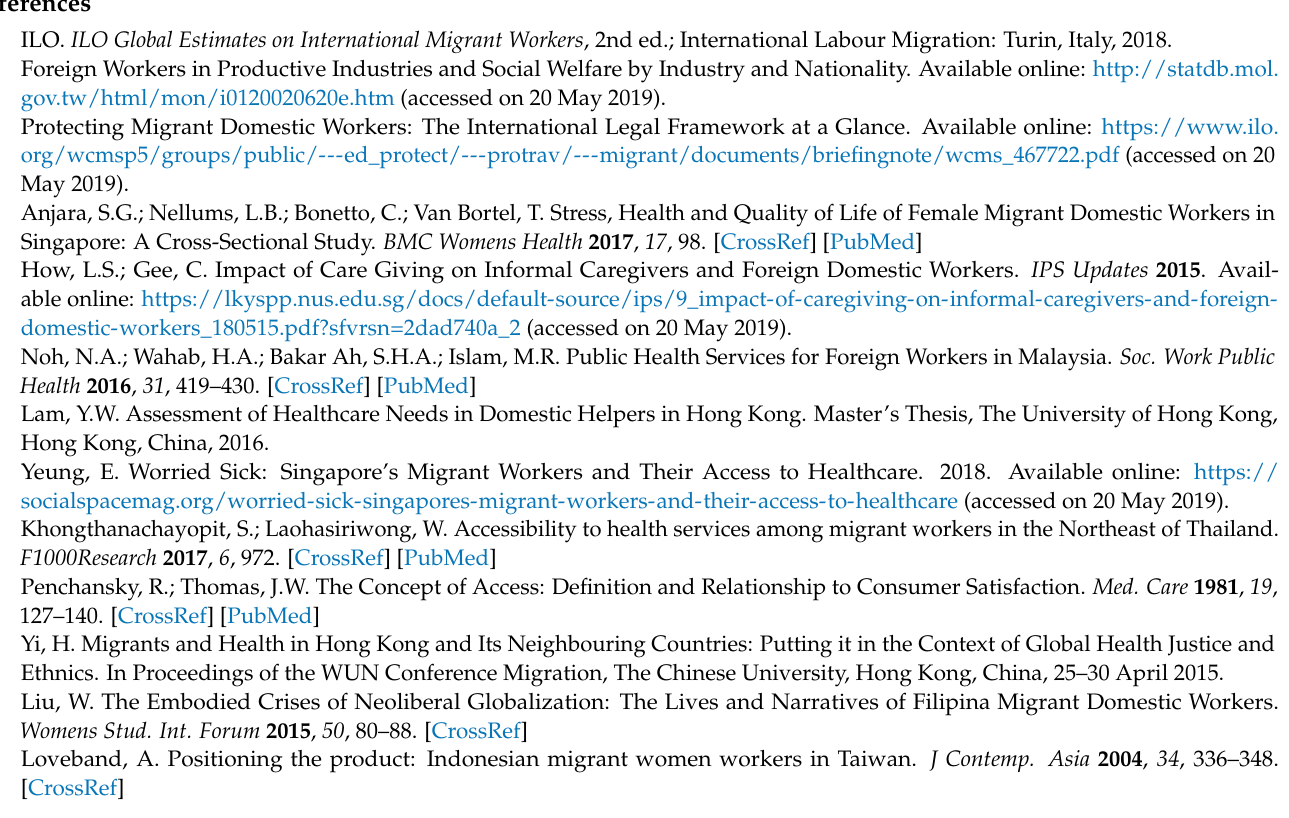
Table S2: Descriptive statistic for availability ( n = 248), Table S3: Descriptive statistic for accessibility ( n = 248), Table S4: Descriptive statistic for accommodation ( n = 248), Table S5: Descriptive statistic for affordability, Table S6: Descriptive statistic for